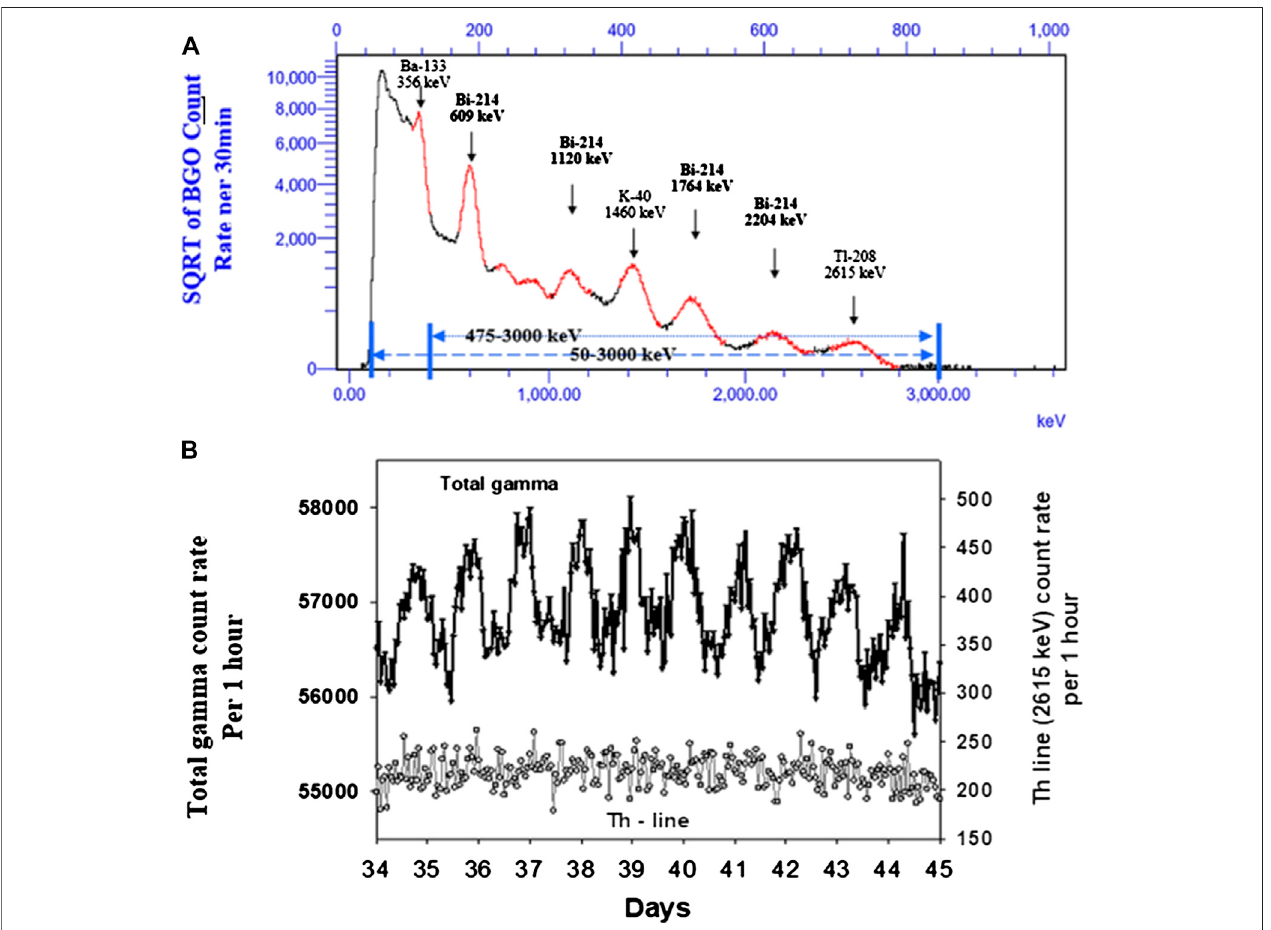
FIGURE 1 | (A) The Gamma spectra of Uranium, Thorium, and Potassium, measured using a 3 ″ × 3 ″ NaI scintillator. It displays the Bi-214 energy (RDP) lines of 609, 1,120, 1,764, and 2,204 keV in the gamma-ray spectra from magmatic rocks. The spectrum includes also energy lines of U-238 and Th-232 decay products and theisotopeK-40.TheBa-133lineisduetoanarti fi cialsourceaddedforthestabilizationoftheelectronicampli fi cationoftheMCA(MultiChannelAnalyzer). (B) A10-days measurement exhibiting the total daily gamma variations due to the RDPs, while the gamma level of the thorium decay products within the rock is stable. This demonstrates the use of total gamma measurement to track temporal variations of radon in a soil or country rock media.